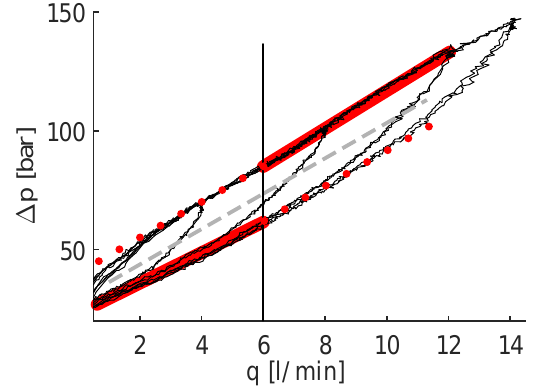
Figure 18: p Pe (q) with q limited to 4, 8, 12 and 14L/min (black). Median curve (dashed grey). Data with fully developed friction (red). Corrected data (dotted red).